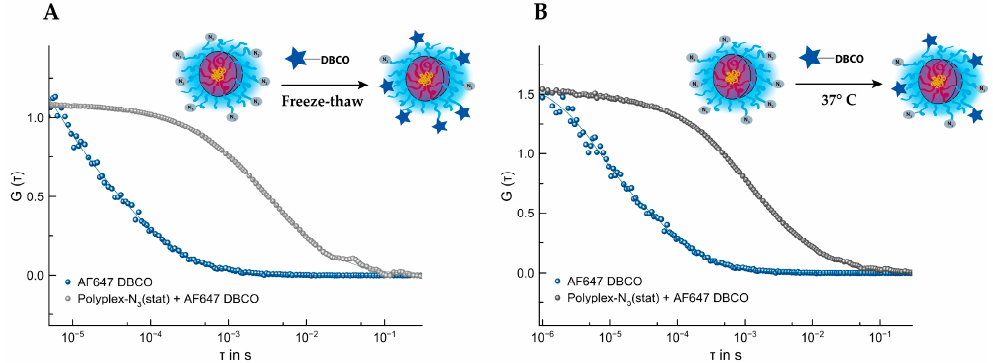
Figure 6. FCS: SPAAC of polyplex by P(Lys)- b -P(HPMA)-N 3 (stat) and AF647 DBCO: ( A ) SPAAC via freeze-thaw cycles; blue line: AF647 DBCO: R h = 0.75 nm; light grey line: SPAAC of polyplex: P(Lys)- b -P(HPMA)-N 3 (stat) and AF647-DBCO: R h = 52 nm (97%). ( B ) SPAAC at 37 °C; blue line: AF647 DBCO: R h = 0.75 nm; dark grey line: SPAAC of polyplex: P(Lys)- b -P(HPMA)-N 3 (stat) and AF647-DBCO: R h = 50 nm (90%).